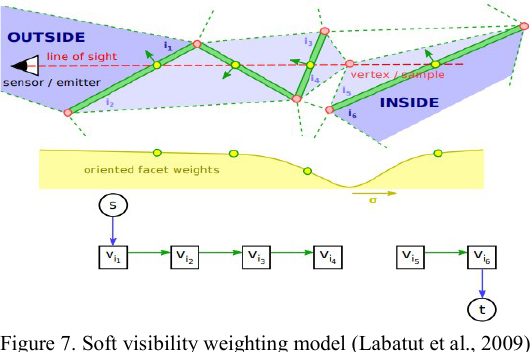
Figure 7. Soft visibility weighting model (Labatut et al., 2009)